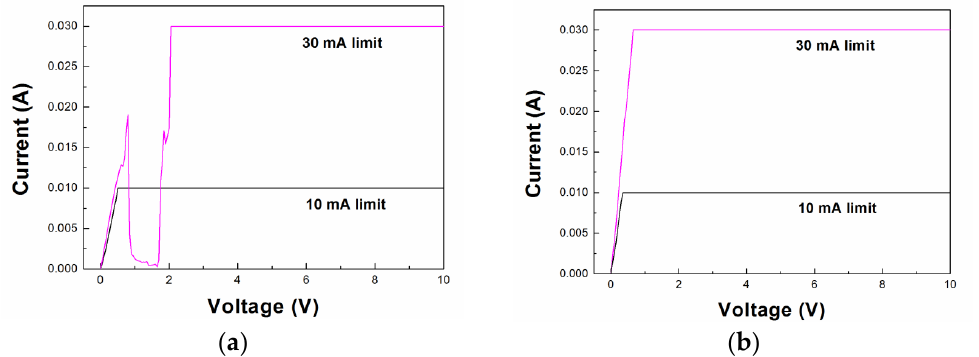
Figure 5. I – V characteristics of the programmed antifuses: ( a ) the Al/α -Si:H/Al antifuse and ( b ) the Al/α - Si:H,N/α -Si:H/Al (N-5min) antifuse.